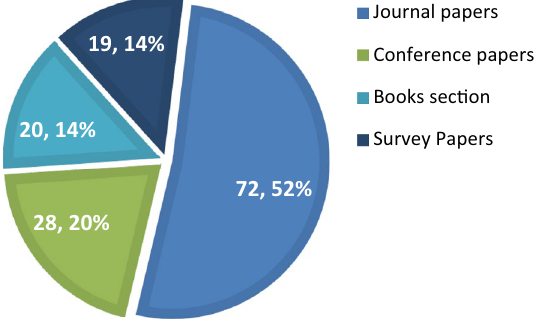
Figure 6. Percentage contribution by type of paper.